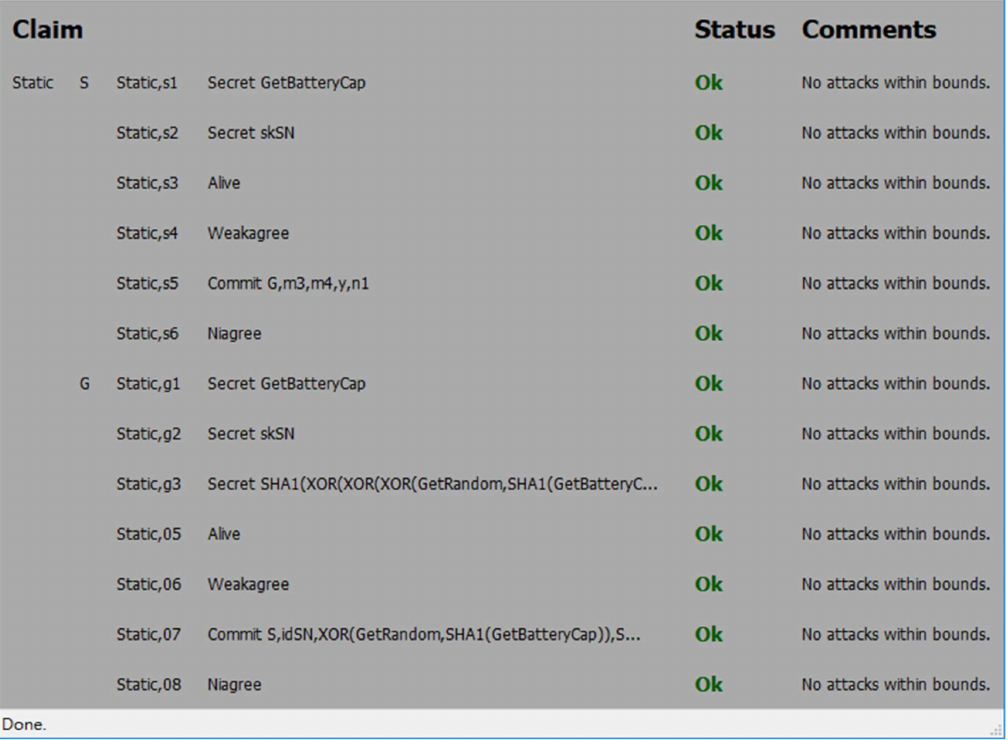
Figure 9. The security analysis result of the static authentication phase of the proposed protocol.